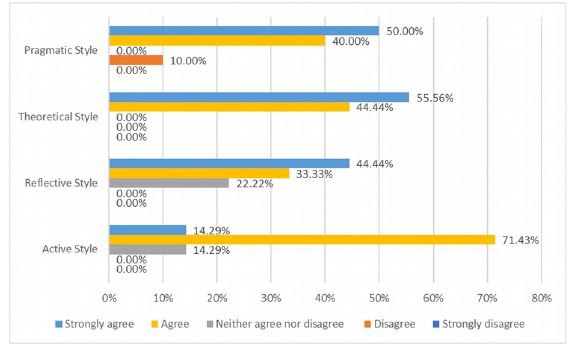
Figure 8. I can show what I have learned in